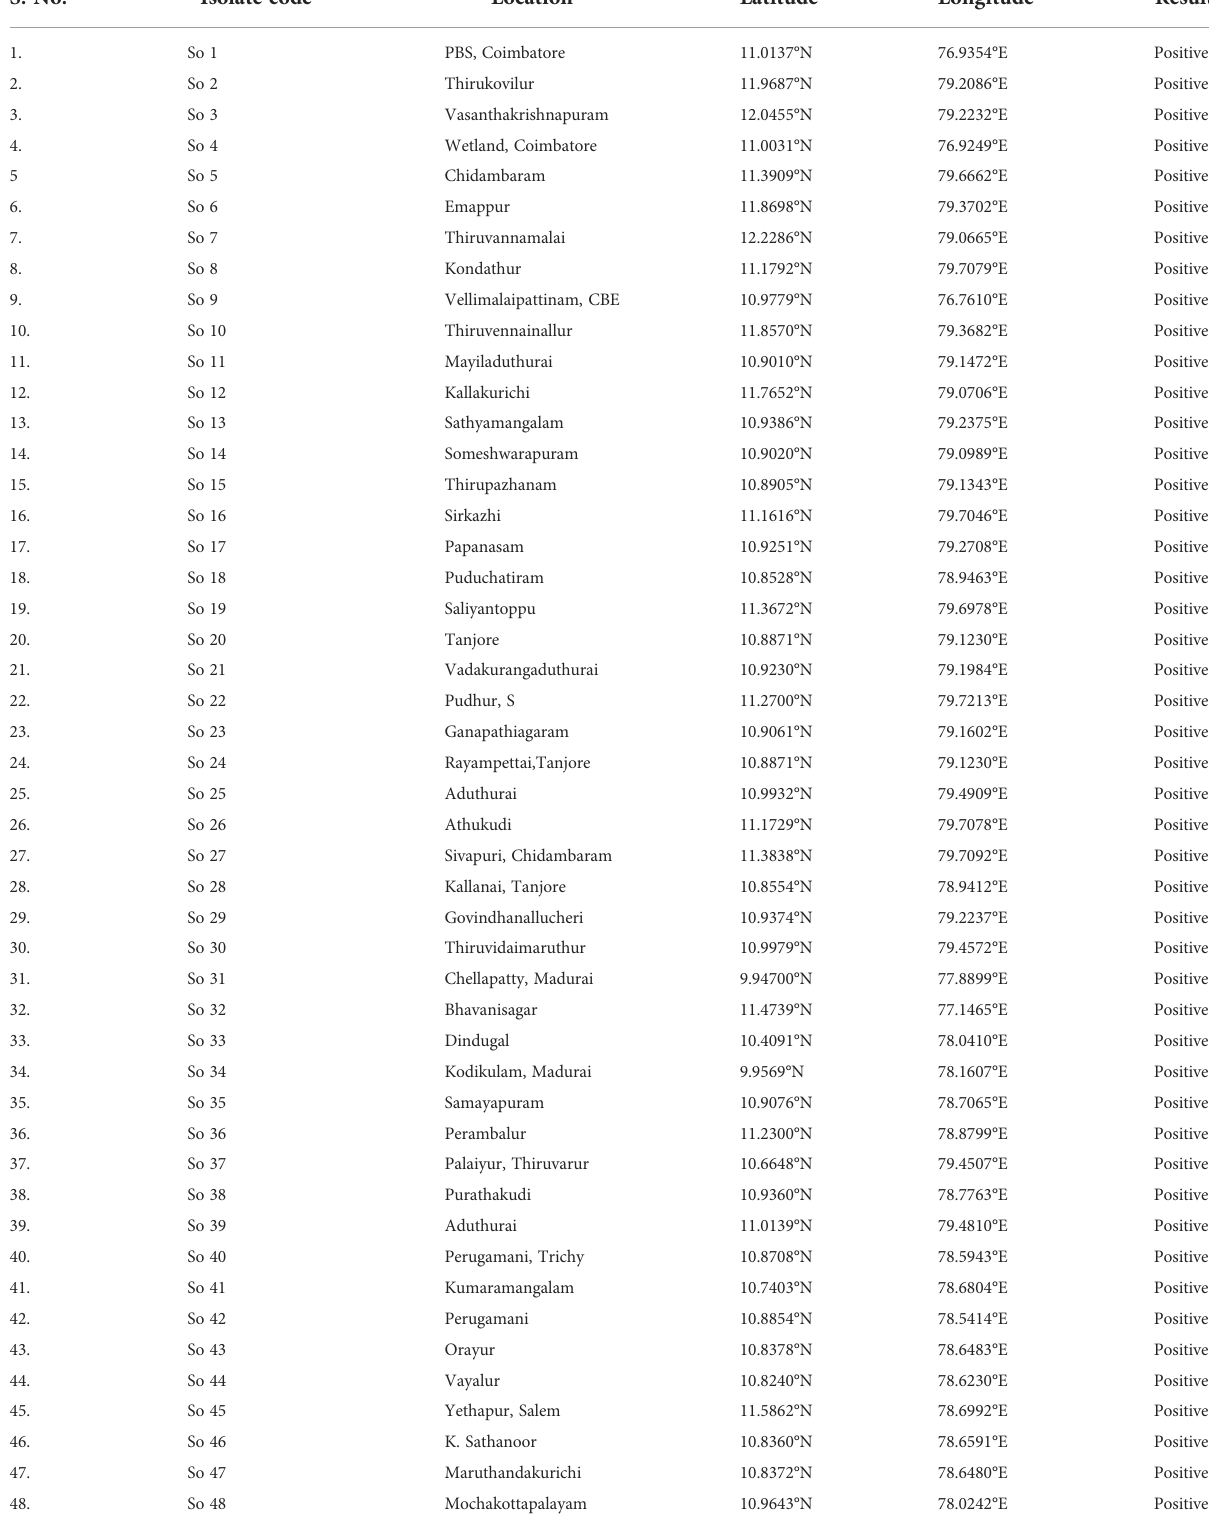
TABLE 5 Validation of LAMP assay for the detection of different isolates of S. oryzae . S.